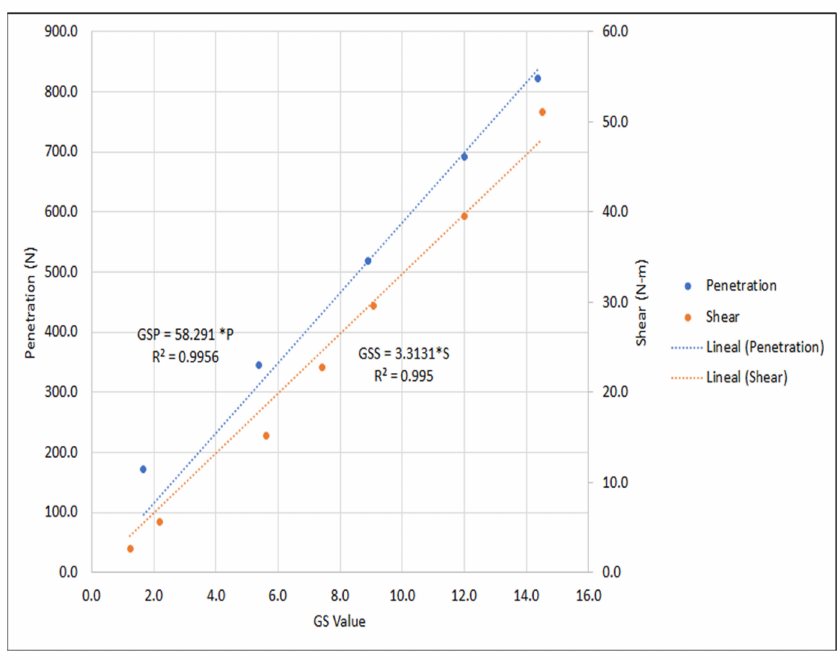
Figure A4. Curve fits assuming linearity to determine conversion factor of GS values of penetration and